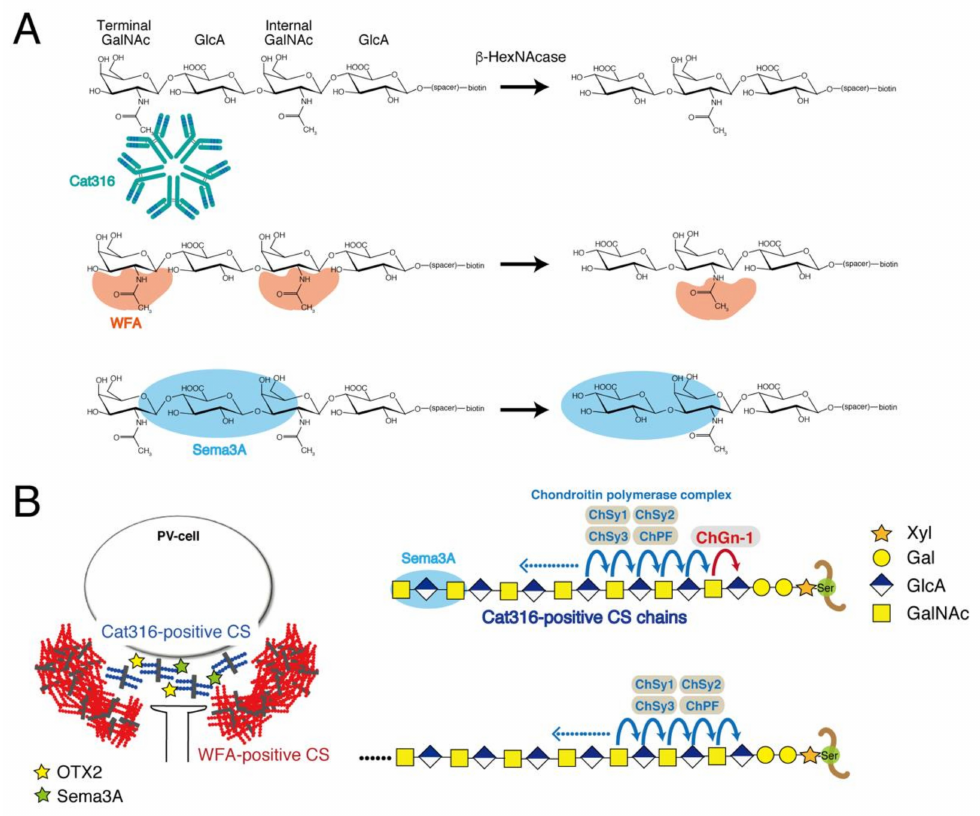
Figure 6. Structural requirements for the binding of Cat316, WFA, and Sema3A ( A ) Cat316 specifically recognizes a GalNAc residue at the non-reducing terminal. In contrast, WFA can bind to both terminal and internal GalNAc residues. Our analysis suggests that Sema3A may bind to non-sulfated CS structures located adjacent to the non-reducing terminus. ( B ) On the left side, WFA- and Cat316-positive PNNs are schematically shown. WFA-positive PNNs form a meshwork surrounding the PV cells. Inside the WFA-positive PNNs, Cat316-positive PNNs are distributed in a punctate pattern rather than a meshwork structure. PNN e ff ectors, such as Sema3A and OTX2, are co-localized with Cat316-positive CS chains. On the right side, a biosynthetic model in which Cat316-positive CS chains are synthesized in a ChGn1-dependent manner is